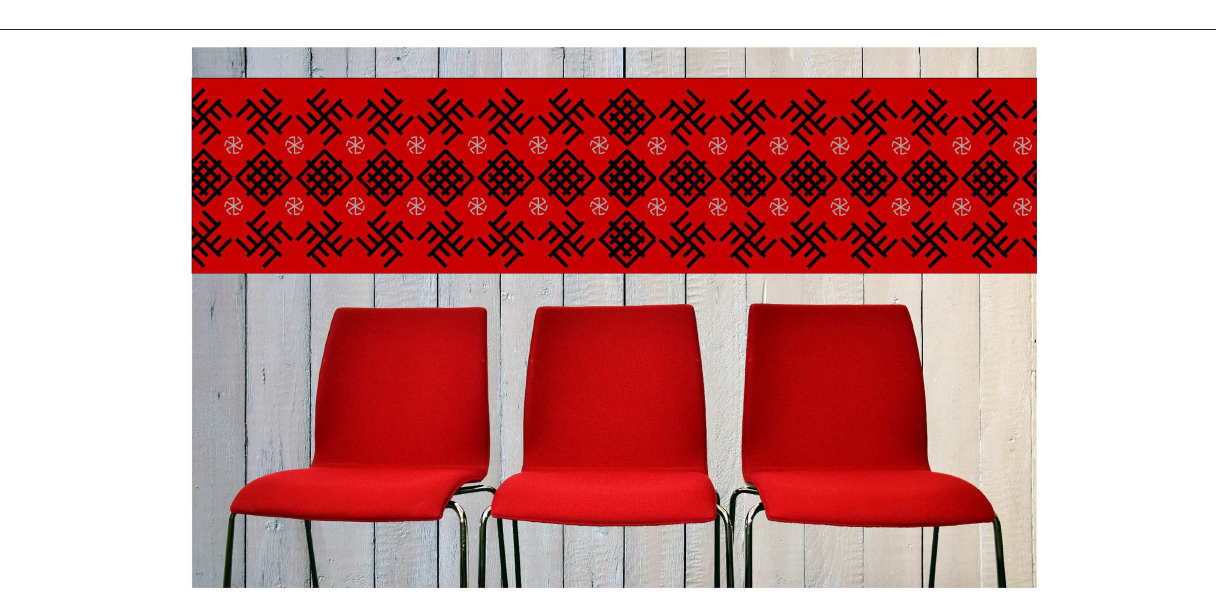
Frontiers in Materials |